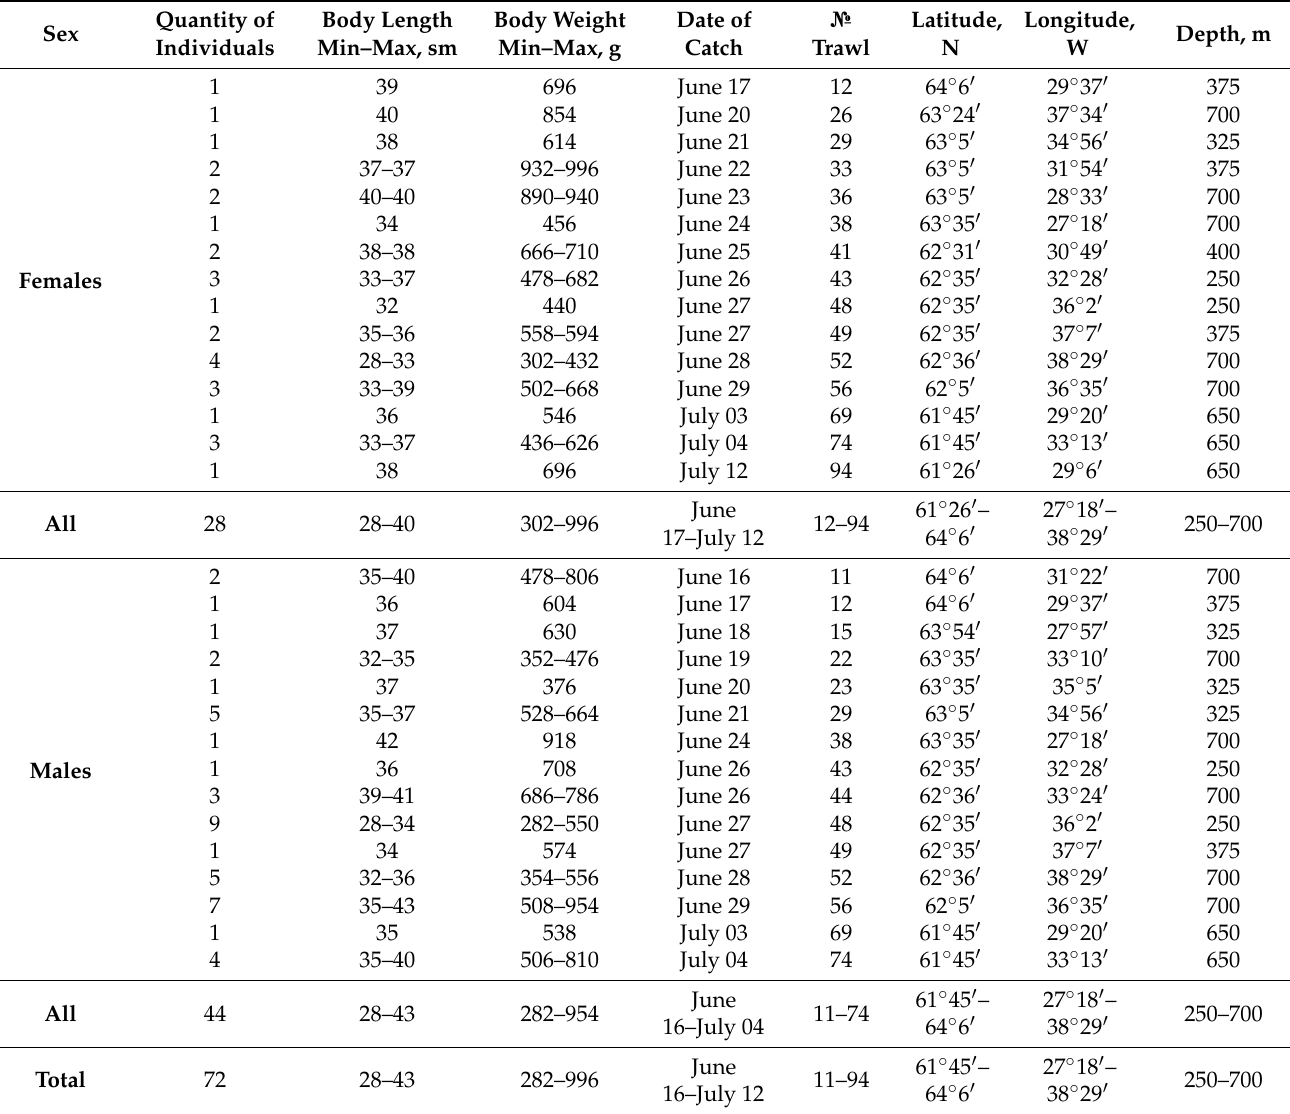
Table 1. Information on the studied individuals of beaked redfish ( Sebastidae